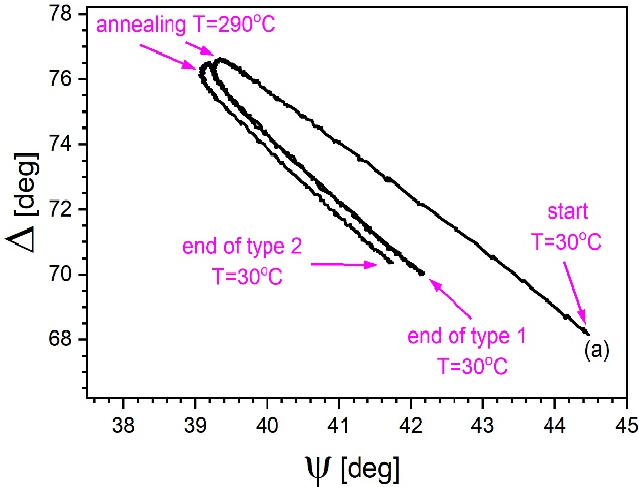
Figure 3. The 20% sample. Dependence of Δ over ψ during the first heating/cooling cycles. The temporal order of presented experimental data is the following: start at 30 °C, heating to 290 °C and annealing, cooling to 30 °C, next heating to 290 °C and annealing, final cooling to 30 °C (see Figure 1). Further in the text, segments of the trace are referred to as “first heating arm”, “first annealing”, “first cooling arm”, “second heating arm”, “second annealing”, and “second cooling arm”, accordingly. Data recorded for 1550 nm, i.e., “fiber optic window”